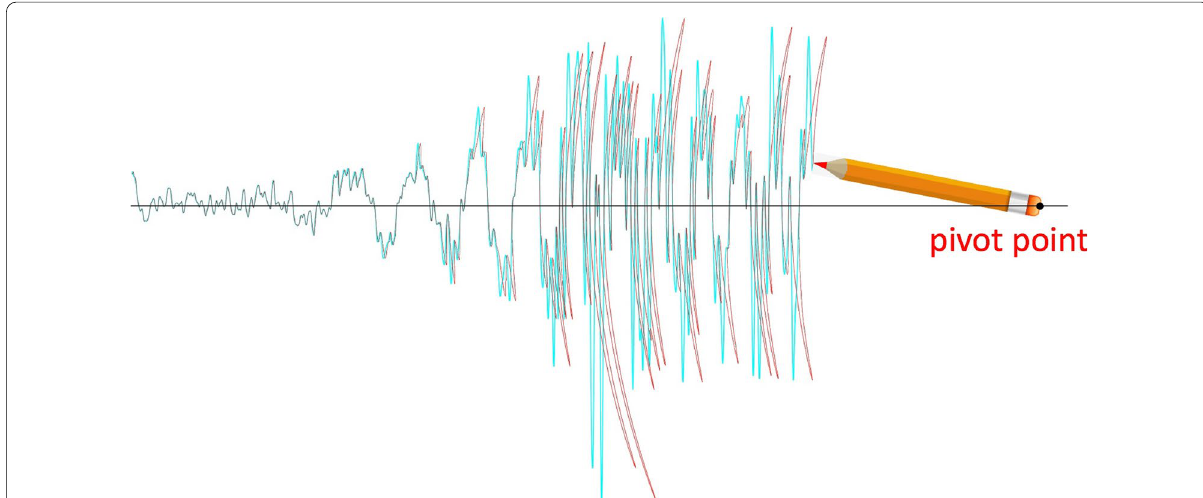
Fig. 7 Curvature introduced by pen-type recording system. Comparison of a raw seismogram showing the beginning of surface-wave arrivals at station HRV from the November 30, 2018, Anchorage earthquake (cyan line), and a version with curvature as would be generated by a pen-type system introduced (red line). The pen (pencil in the figure) swings around a pivot point, making arcs for large-amplitude arrivals, even though for small-amplitude arrivals, the cyan and red lines are practically